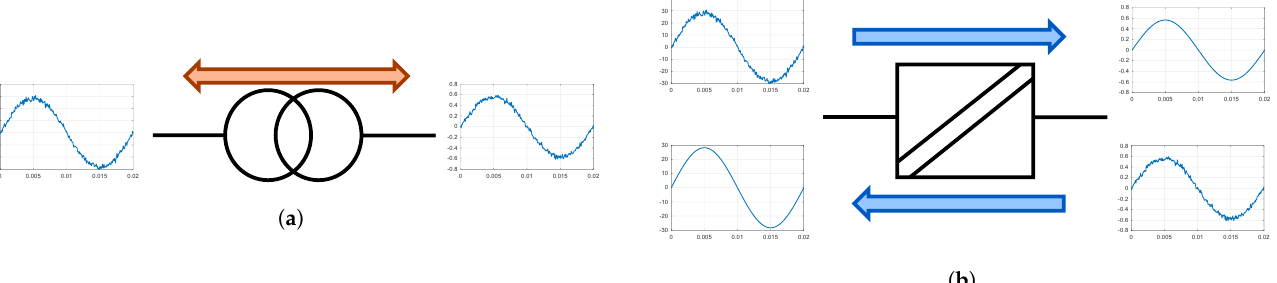
Figure 3. Waveform regeneration feature by a SST device. ( a ) Harmonics can be transmitted from one side to the other in a classic power transformer. ( b ) In SST devices, the signal is built up synthetically at both sides and zero harmonics are replicated from the input to the